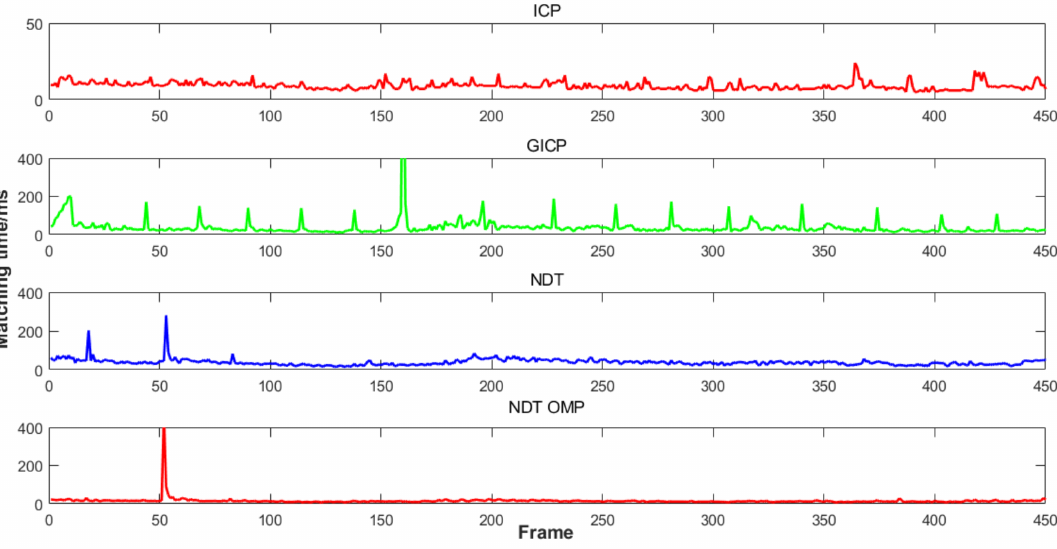
Figure 10. Time consumption of four inter-frame matching